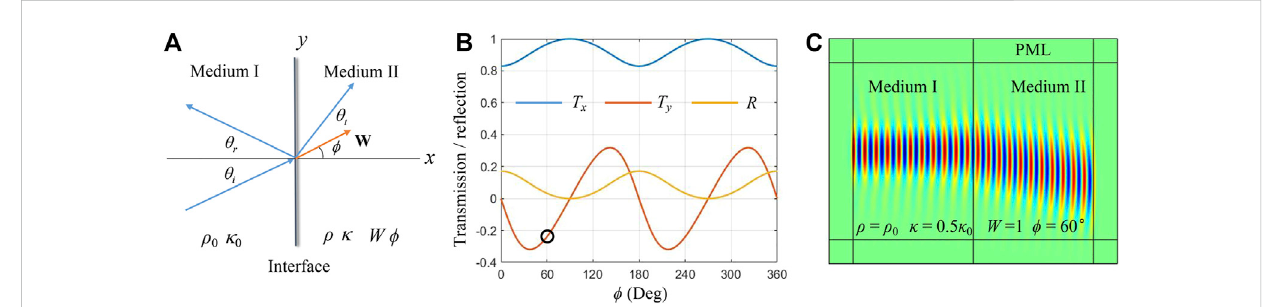
FIGURE 2 (A) Problem setup of the wave transmission across an interface between ordinary acoustic and Willis media. (B) Transmission and re fl ection power vary with ϕ for normal incidence. (C) FEM simulation of a normal incident Gaussian beam, corresponding to the dot in (B)